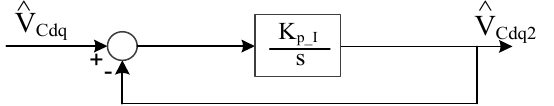
Figure 7. Simplification of capacitor current observer in Figure 6.